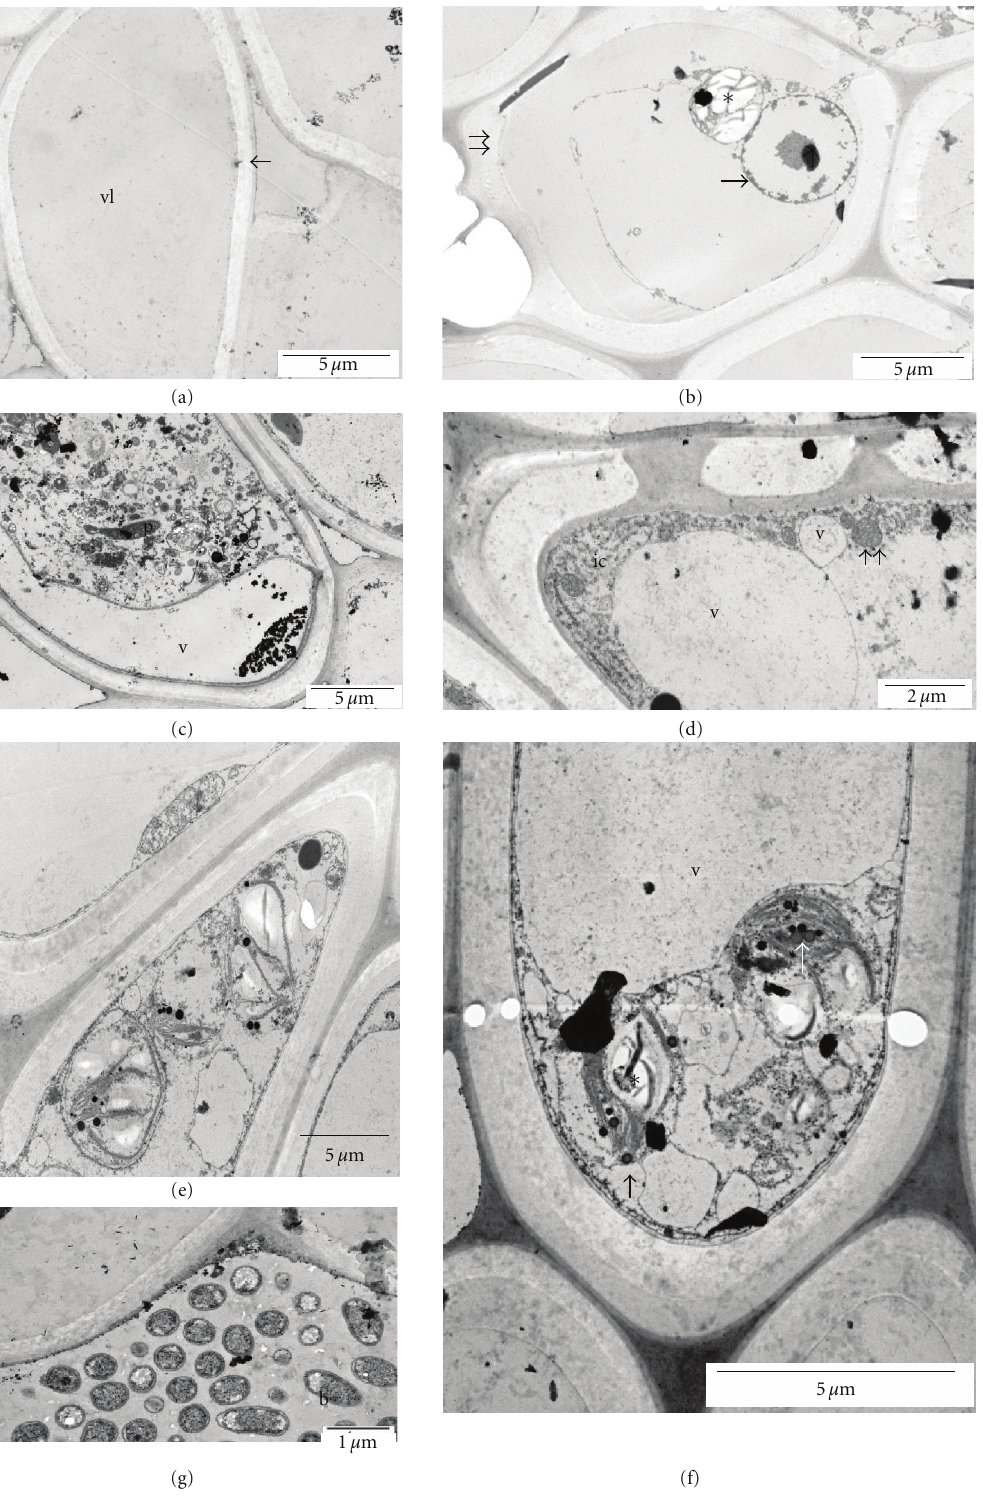
Figure 2: Ultrastructural identification of xylem occlusions in stems of Clematis “Solidarno´s´c” (a) empty vessel, control, (b) young tylose, stems kept in distilled water, date I, (c) mature tyloses, stems kept in distilled water, date II, (d) young tylose, stems kept in 8HQC with 2% sucrose, date I, (e) and (f) mature tylose, stems kept in 8HQC with 2% sucrose, date II, (g) bacteria in blocked vessels, stems kept in 8HQC with 2% sucrose, date II. Vl: vessel lumen, ← : cell wall, ∗ : amyloplast, → : degrading nuclei, ⇒ : tylose cell membrane, P: plastid, ic: intact cytoplasm, v: vacuole, (cid:3) : mitochondria, ↑ : lipid bodies, b: bacteria, Control: term 0, Term I: after 7 days of postharvest life (wilting of flowers kept in distilled water), Term II: and after 12 days, when wilting and loss of a decorative value occurred in flowers placed into the